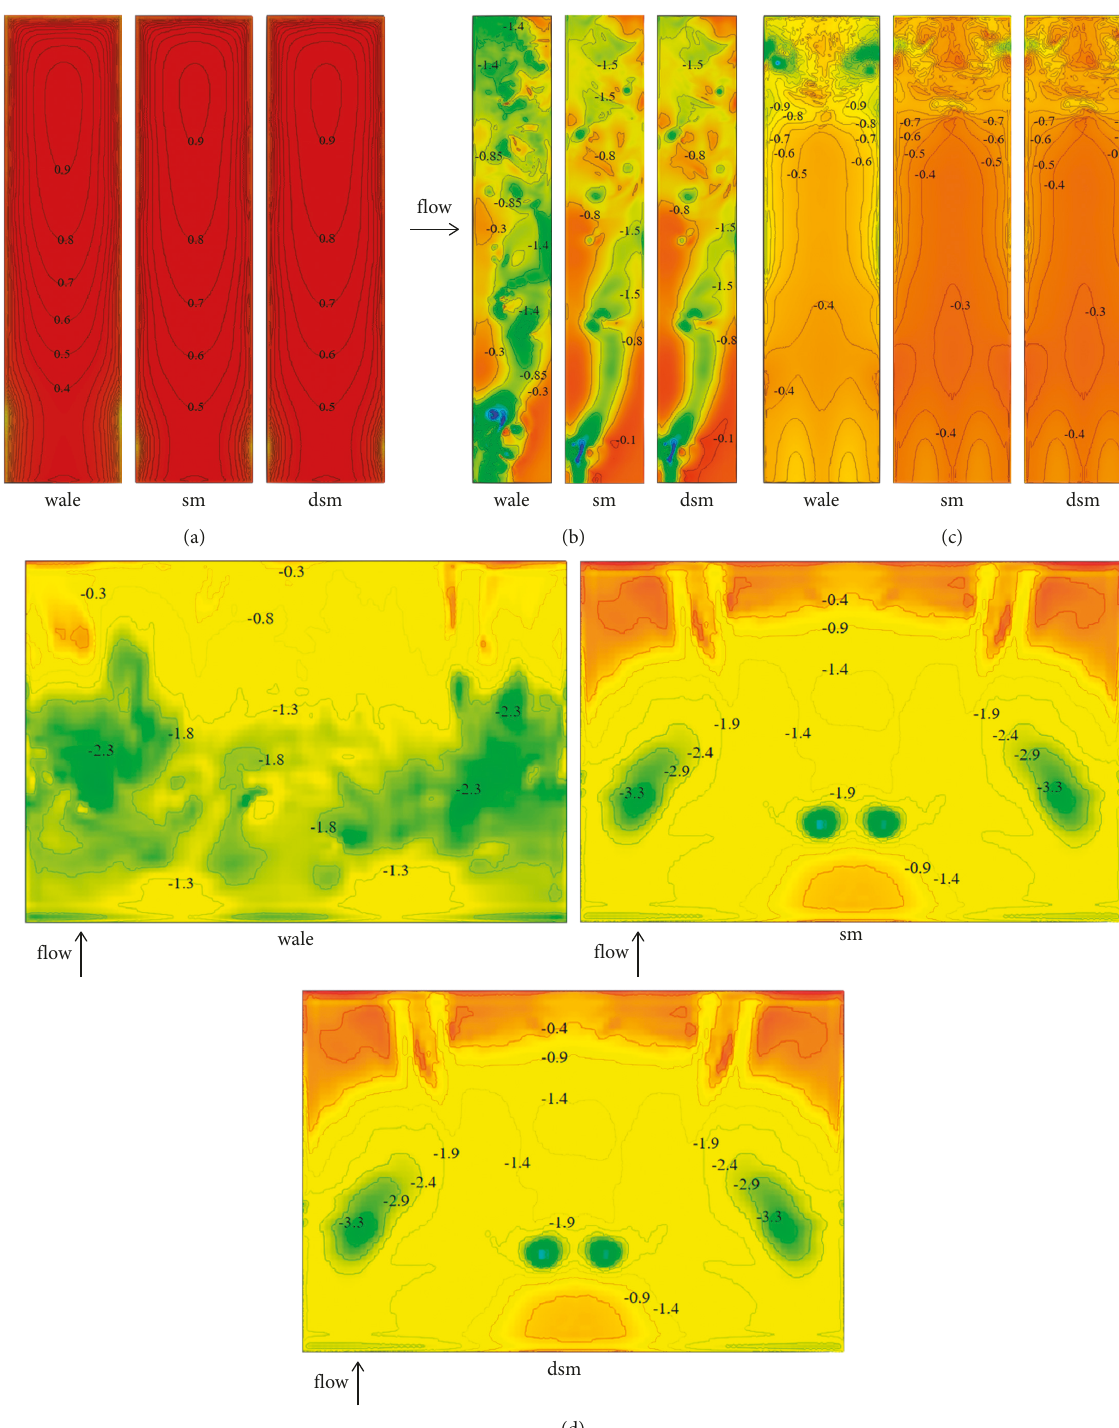
Figure 6: Calculation results of average wind pressure coefficient on the surface of class D wind field at 0 ° wind direction angle. (a) Windward side. (b) Crosswind surface. (c) Leeward side. (d) Top